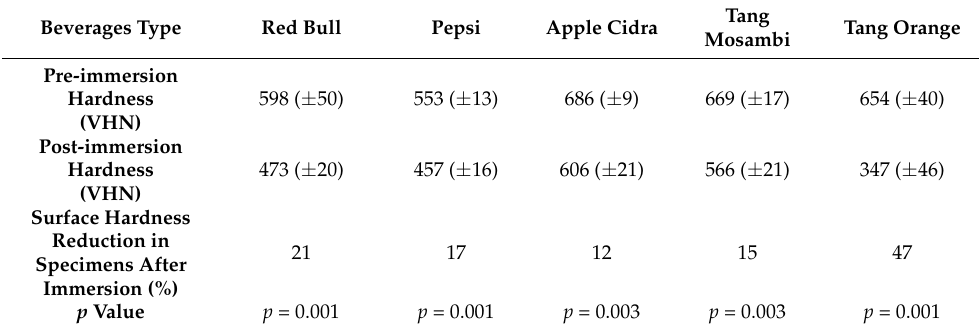
Table 8. Surface hardness of specimens before and after immersion in highly acidic beverages (mean and